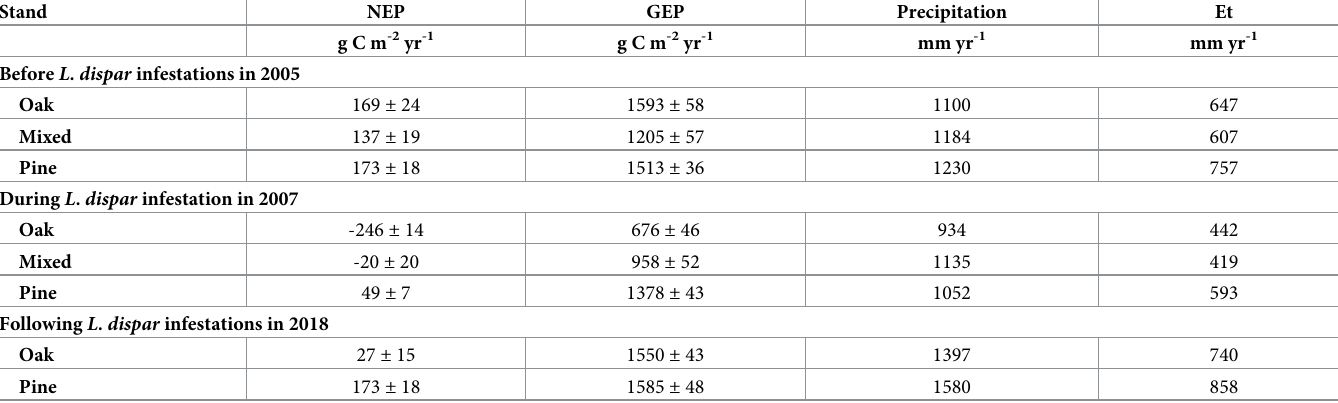
Data are for years before, during, and following L . dispar infestations. Error terms were calculated from maximum deviations from average values generated using ± 1 SE of parameter values used to gap-fill missing half-hourly daytime and nighttime NEE (see [13, 30] for complete description of gap-filling procedures and error term